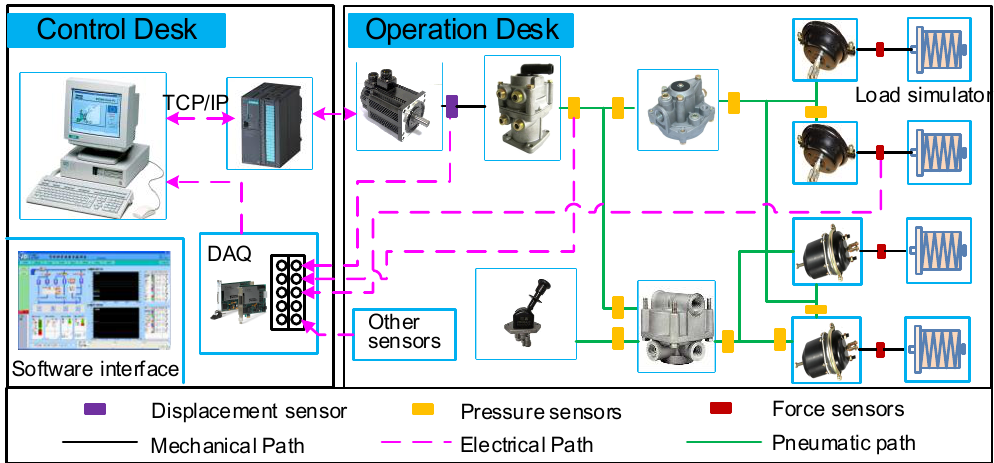
Figure 3. Schematic diagram of the test bench (all the sensors are connected to the data acquisition cards). TCP: transmission control protocol; IP: internet protocol; DAQ: data